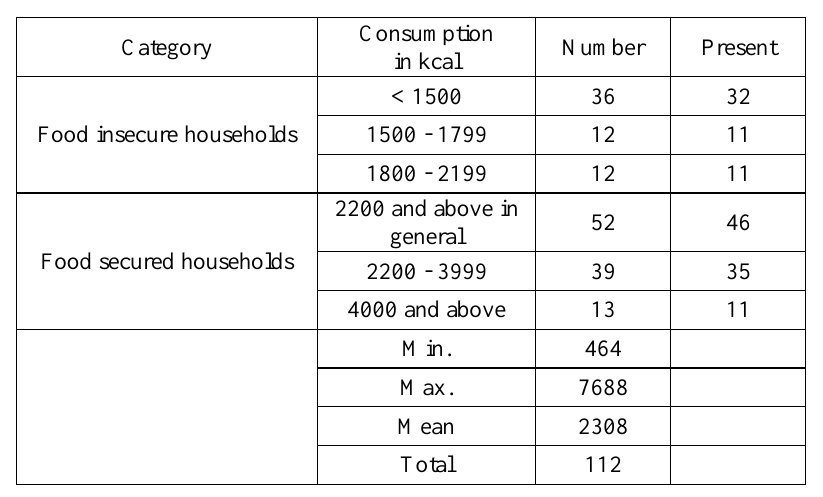
Table 6. Daily energy consumption in kcal per AE of sample households